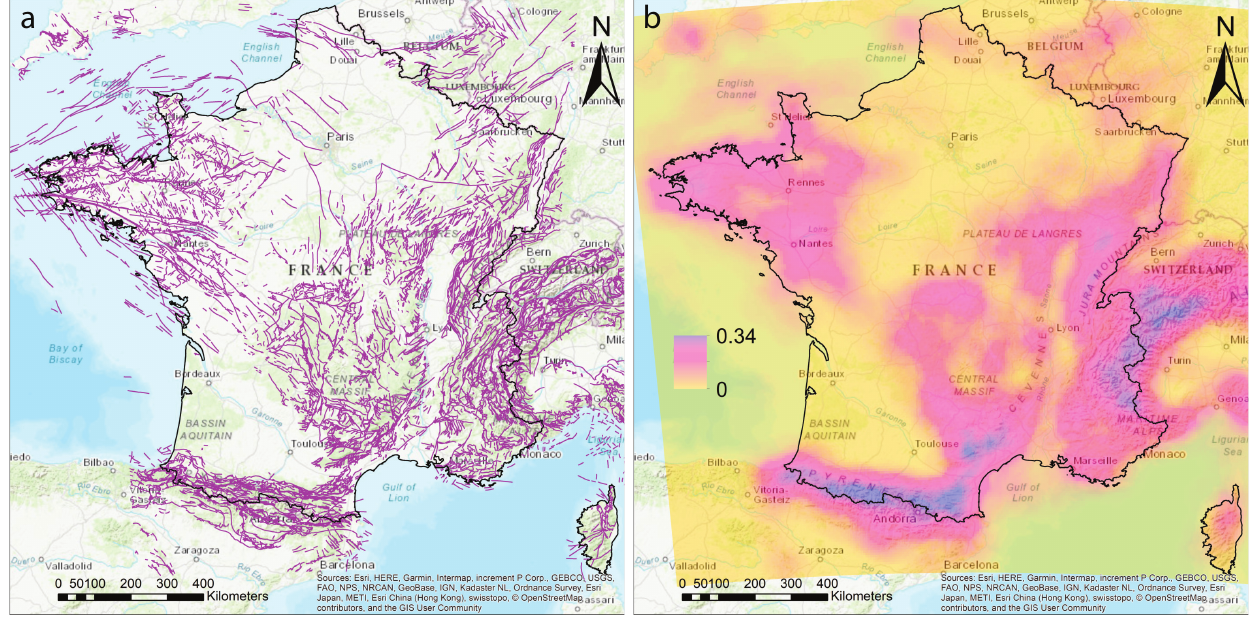
Figure 6. ( a ) Fault traces map of the French territory (CHARM database of BRGM). ( b ) Spatial density map of fault